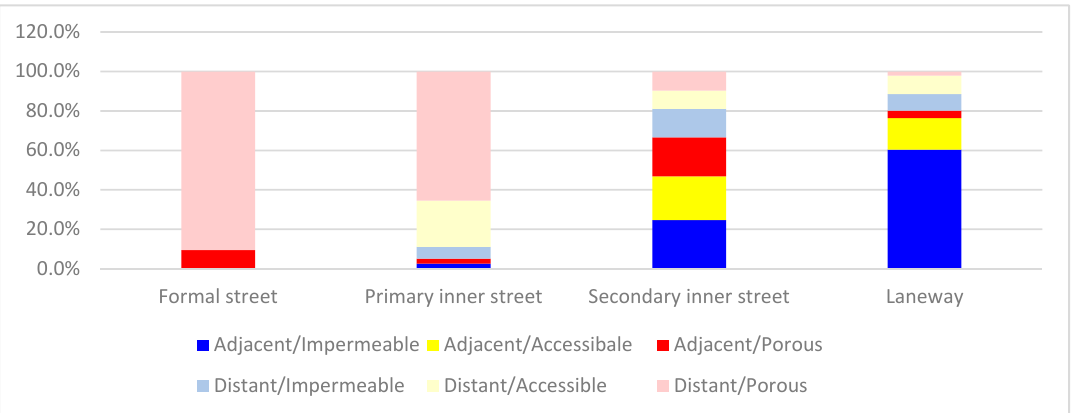
Figure 15. Percentage of the length of different types of interfaces.